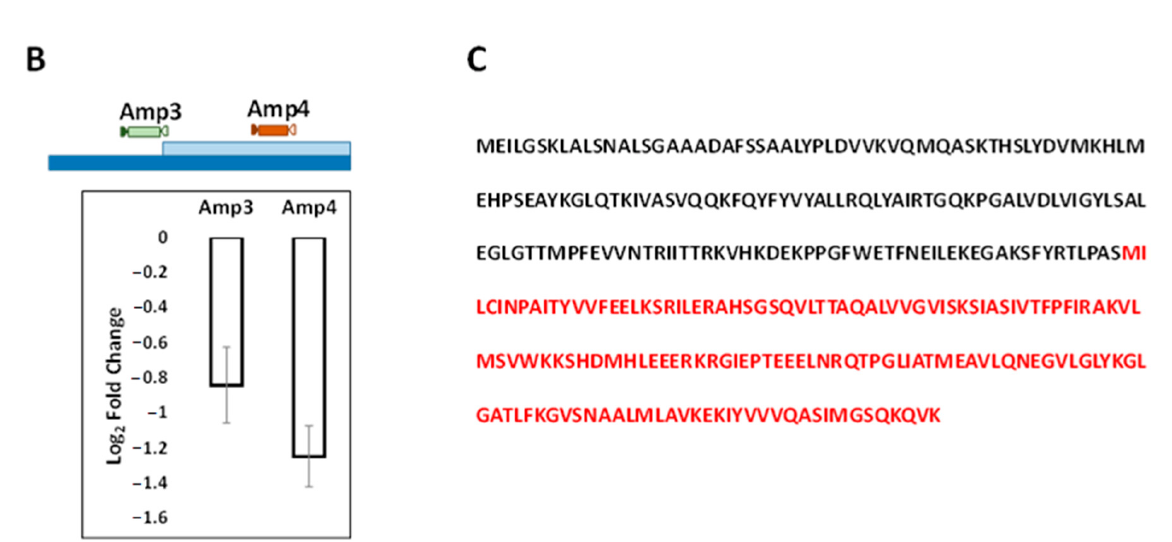
Figure 5. Genomic and transcriptomic analyses of g11073. ( A ) Genomic and transcriptomic analyses of the region containing the g11073 gene with Canu assembler software (Canu v1.9). This analysis shows the coverage of aligned short reads (Illumina) for RNA-seq and the coverage of aligned long reads (PacBio) for DNA-seq. ( A ) A 2-fold decrease of the DNA-seq coverage was recorded in the 5 (cid:48) region of the locus in LAS, but not in WT, indicating important biolistic damages. ( B ) The qRT-PCR analysis of g11073 expression level in LAS versus WT at day 3, using two different amplicons (Amp3 and Amp4). The level of expression in WT is set at 0. ( C ) In silico translation of the g11073 gene. The putative truncated protein is in red, starting from the first methionine following the